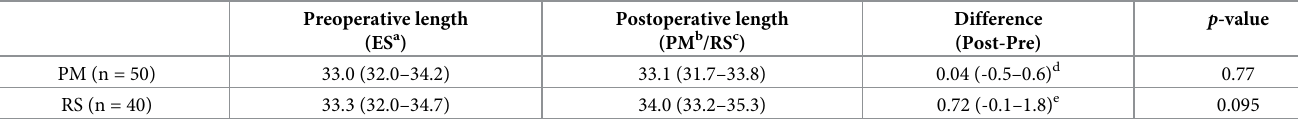
Table 2. Length of each route and difference between post- and preoperative